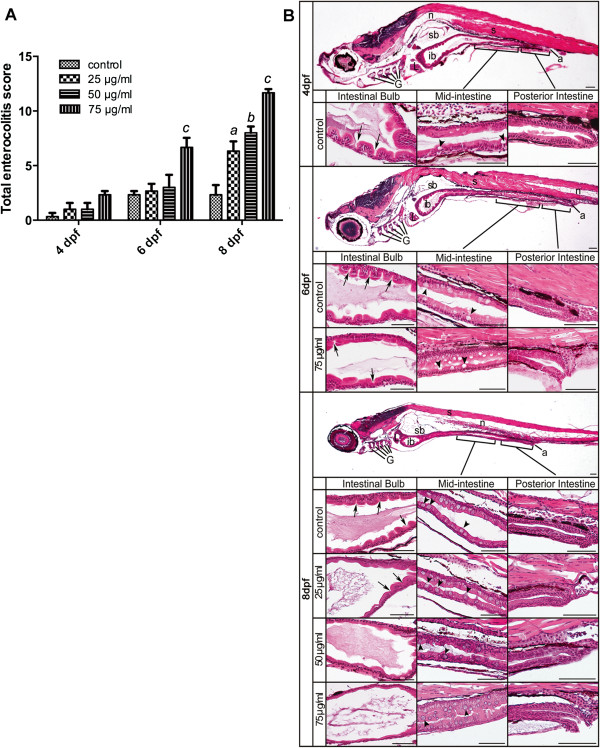
Histological analysis of TNBS-induced enterocolitis. A: Total enterocolitis score of larval zebrafish exposed to different TNBS concentrations (0, 25, 50 and 75 μg/ml) at 4, 6 and 8 dpf. The scores were quantified by a blinded scorer. For each score, a total of 30 folds (10 per intestinal segment) were evaluated per intestine and 6 intestines were evaluated for each experimental group from three independent experiments. All error bars represent as mean ± SEM. n=6 larvae per group, aIndicates a significant difference (p<0.05) between TNBS-exposed group (25 μg/ml) and the control, bIndicates a significant difference (p<0.05) between TNBS-exposed group (50 μg/ml) and the control, cIndicates a significant difference (p<0.05) between TNBS-exposed group (75 μg/ml) and the control, dIndicates a significant difference (p<0.05) between control groups at 6 dpf and 4 dpf, eIndicates a significant difference (p<0.05) between control groups at 8 dpf and 4 dpf. B: Representative haematoxylin-eosin stained sagittal sections of the whole intestine tact and regions of the intestinal bulb, the mid-intestine and the posterior intestine from the statistically significant groups taken at 4, 6 and 8 dpf. In the segment of the intestinal bulb (ib), the lumen expands and the depth of epithelial folds is progressively reduced during TNBS exposure (arrows). The mid-intestine is demarcated by the presence of goblet cells and shows increased numbers with TNBS treatment (arrowheads). No significant changes are shown in the posterior intestine region between control and TNBS-exposed samples. a, anus; ib, intestinal bulb; G, gill arches; L, liver; sb, swim bladder; n, notochord; s, somite. Scale bars, 50 μm.